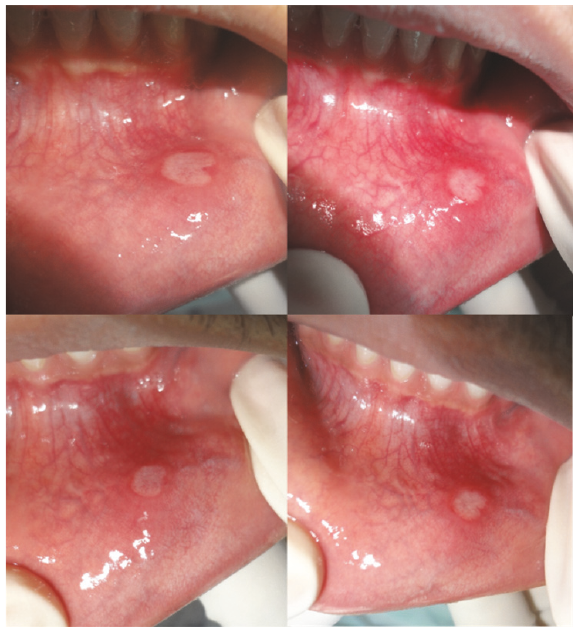
Figure 3: Ulcer healing seen in group B.